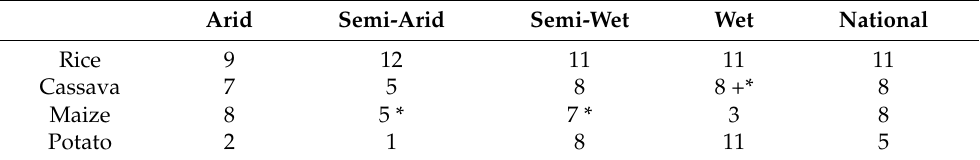
Table 3. The optimal number of months for the soil-moisture-averaging period for each crop over the four climate-zones and nationally. This optimal length is determined by maximizing the absolute correlation coefficient ( r ) between variations in soil moisture and production. The start of the averaging period varies within the regions based on the minimum NDVI of each 0.05-degree grid box. Arid Semi-Arid Semi-Wet Wet National Rice 9 12 11 11 11 Cassava 7 5 8 8 +* 8 Maize 8 5 * Potato